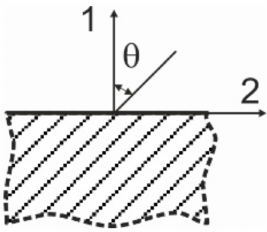
Figure 4. Notation of reinforcement angle in the material